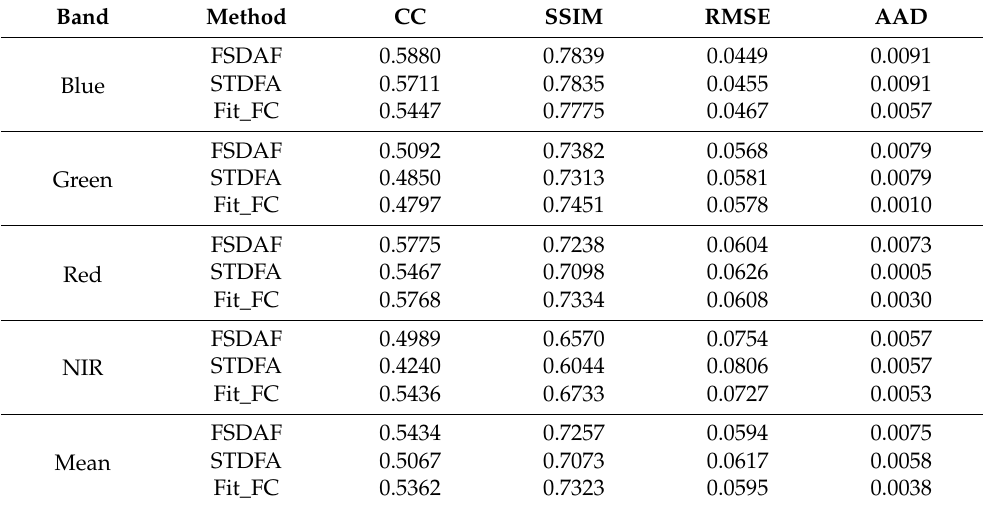
Table 4. The fusion accuracy evaluation of different bands for different